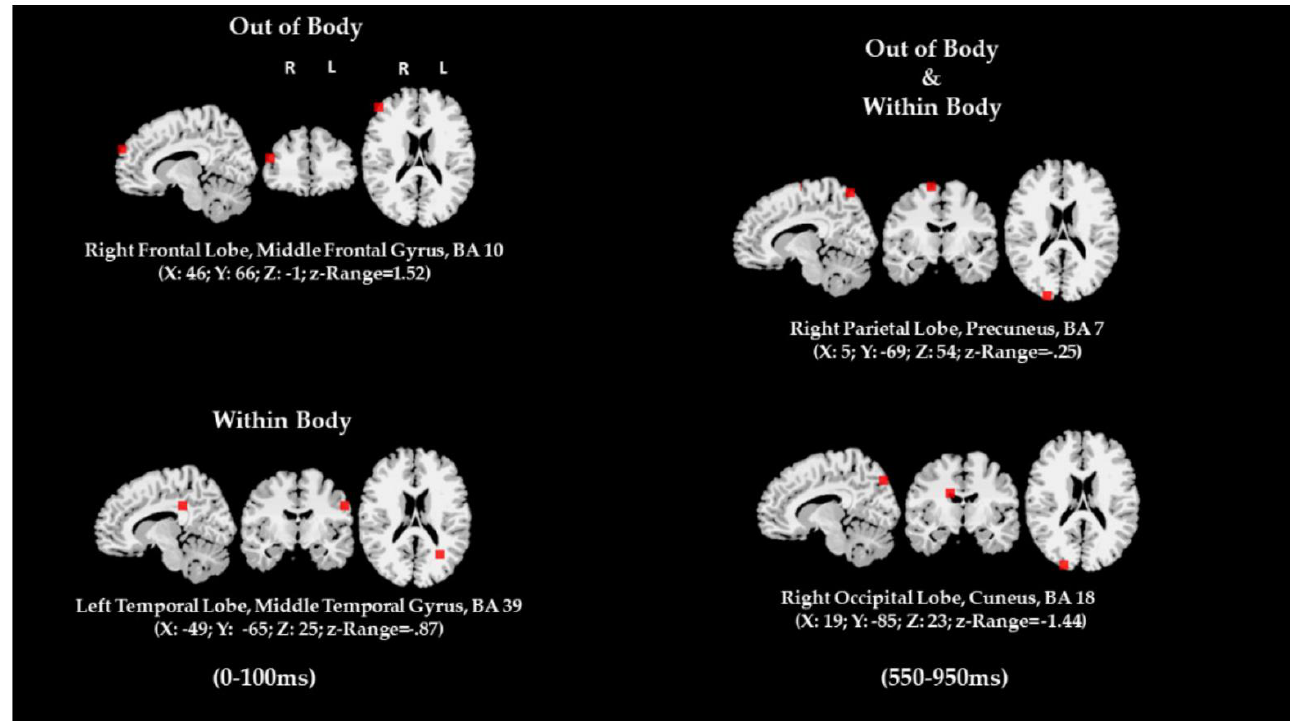
Figure 6. Vivid imagery experienced outside and within the body shows both similar and distinct loci of activation in the brain. Figure taken from D’Angiulli et al. [77]. Red points indicate the estimated anatomical graphic location of the generating source of EEG activity on the structural MRI template slices (i.e., sagittal, coronal, axial); the formal label, Talairach coordinates, and millisecond detection time intervals are given below the template according to Broadman Areas (BA).